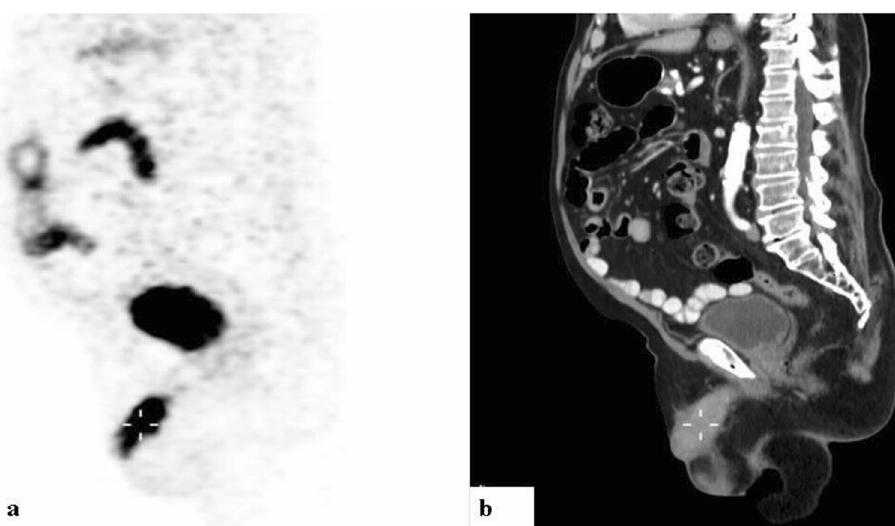
Figure 1. Ga-68 PSMA-PET ( a ) and CT ( b ) sagittal slices demonstrating diffusely increased uptake along the penis. A 71-year-old man with metastatic prostate cancer of neuroendocrine differentiation, in the absence of prior prostatectomy, with a Gleason’s score of 7 and a PSA of 3 (patient #5, Table